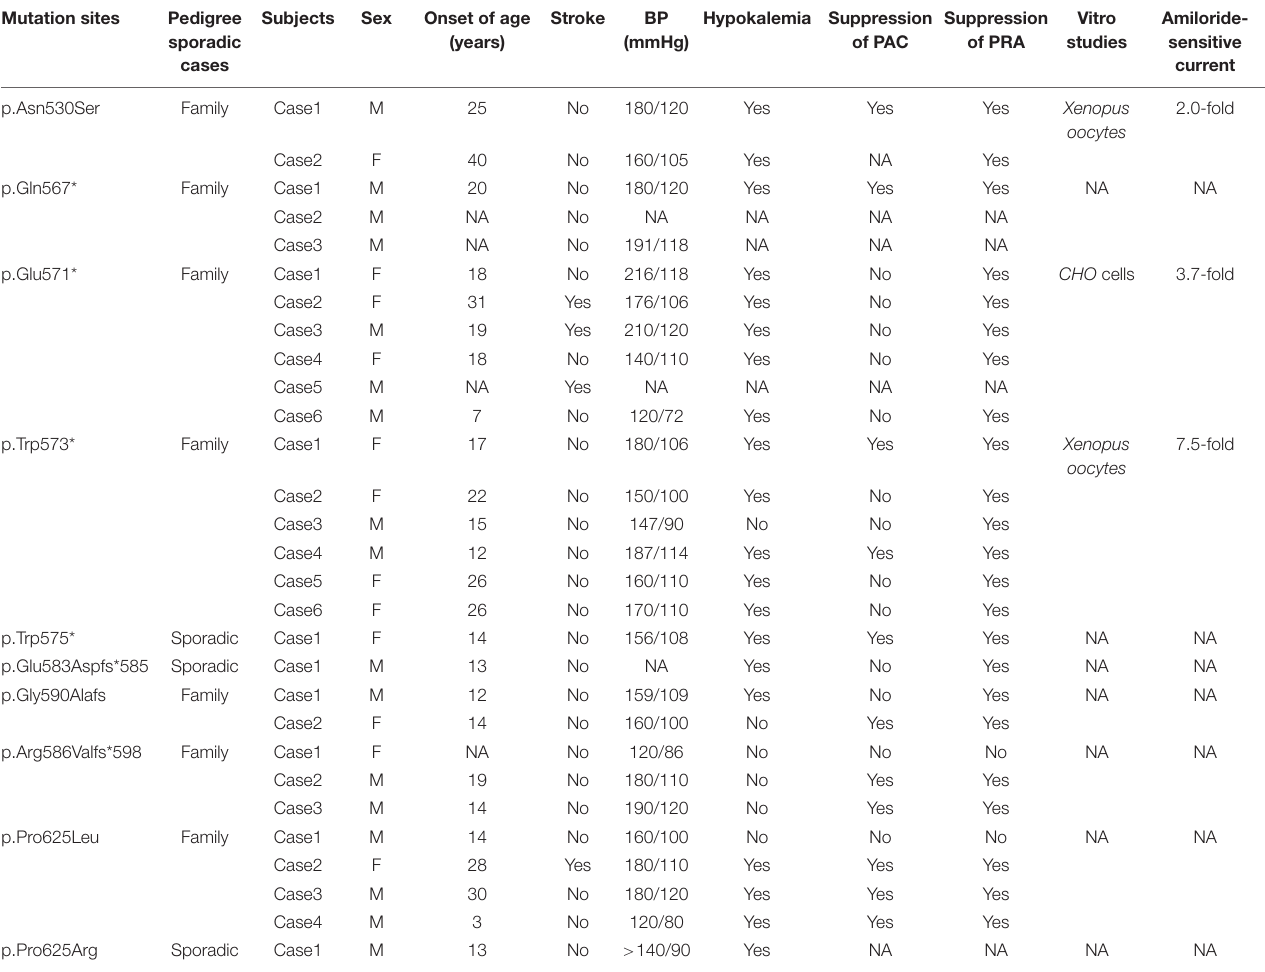
TABLE 2 | Results of systematic review of published studies regarding LS patients carrying SCNN1G mutations. Mutation